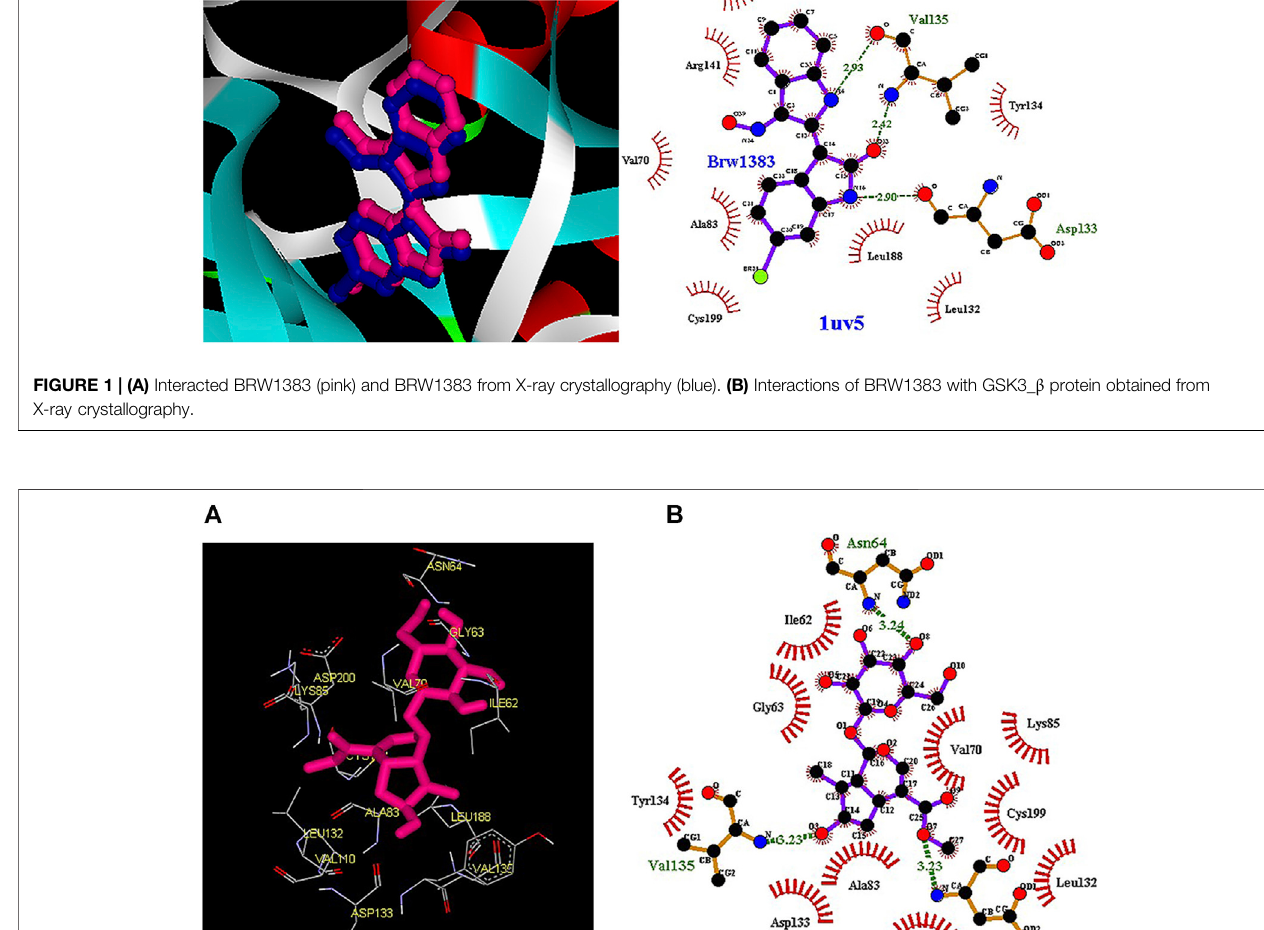
Frontiers in Chemistry |